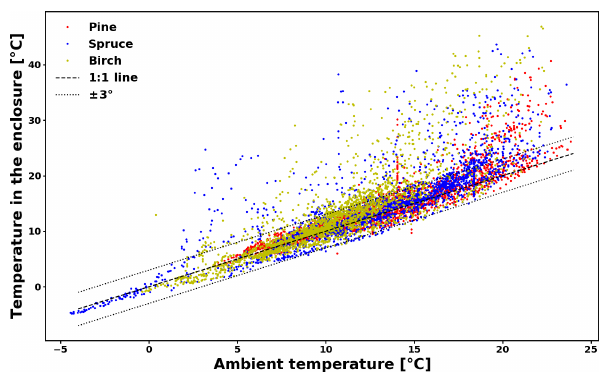
Figure C1. Temperature inside the enclosure compared to ambient temperature.